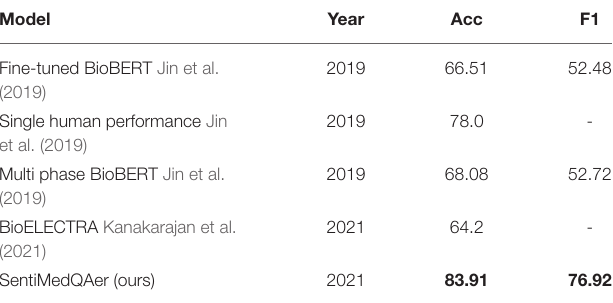
TABLE 10 | Comparison with the